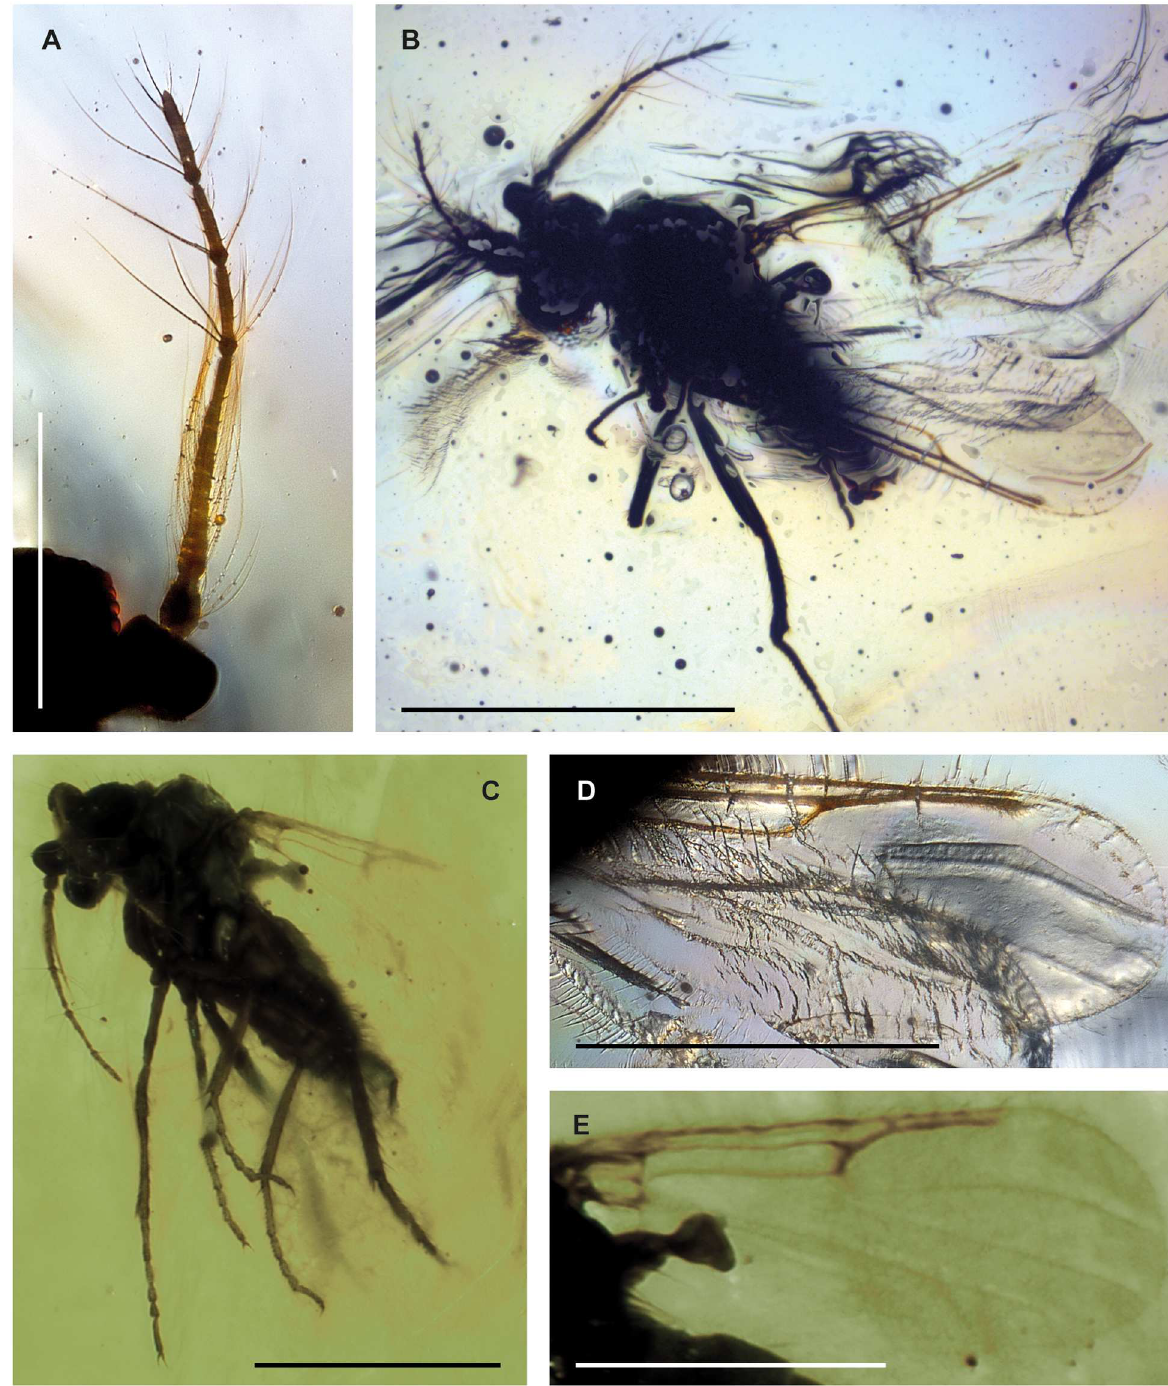
Fig 7. Males of Meunierohelea borkenti n. sp. (holotype, Tad-516) and Meunierohelea orientalis n. sp. (holotype, Tad-858 a) from early Eocene Cambay amber. A . M . borkenti n. sp., antenna. B . M . borkenti n. sp., habitus. C . M . orientalis n. sp., habitus D . M